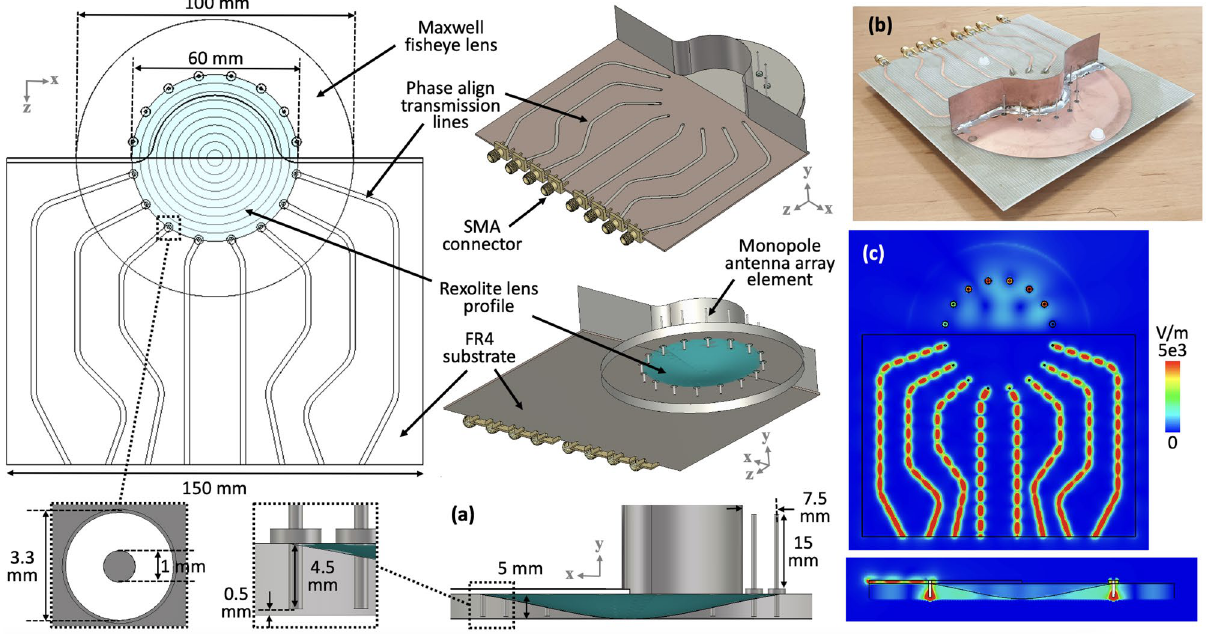
Figure 2. ( a ) Design configuration of the Maxwell fisheye lens beamformer with transmission line network developed for prototyping and performance evaluation, ( b ) Prototype hardware, and ( c ) Simulated E -field mapped on multiple 2D surfaces on the beamformer